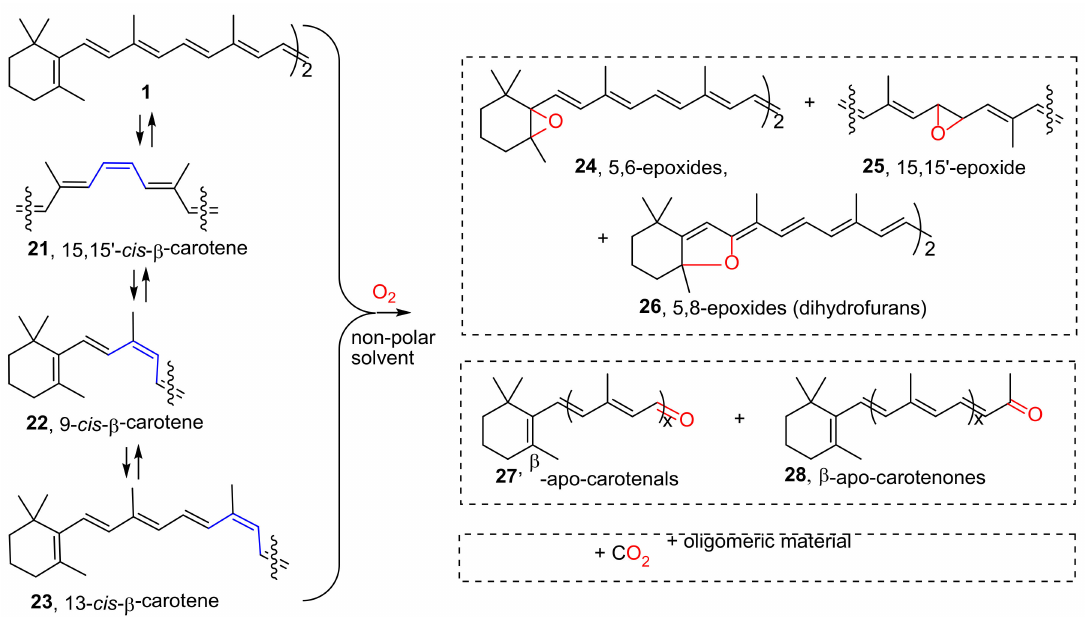
Scheme 1. Product types from the self-initiated oxidation of carotenes by molecular